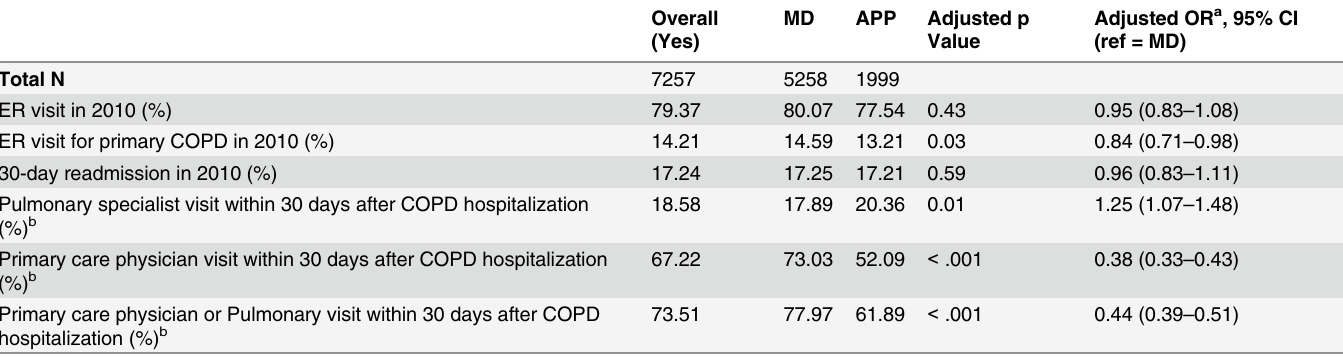
Table 3. Outcomes of COPD patients cared for by a primary care physician or an Advance Practice Provider (APP) during